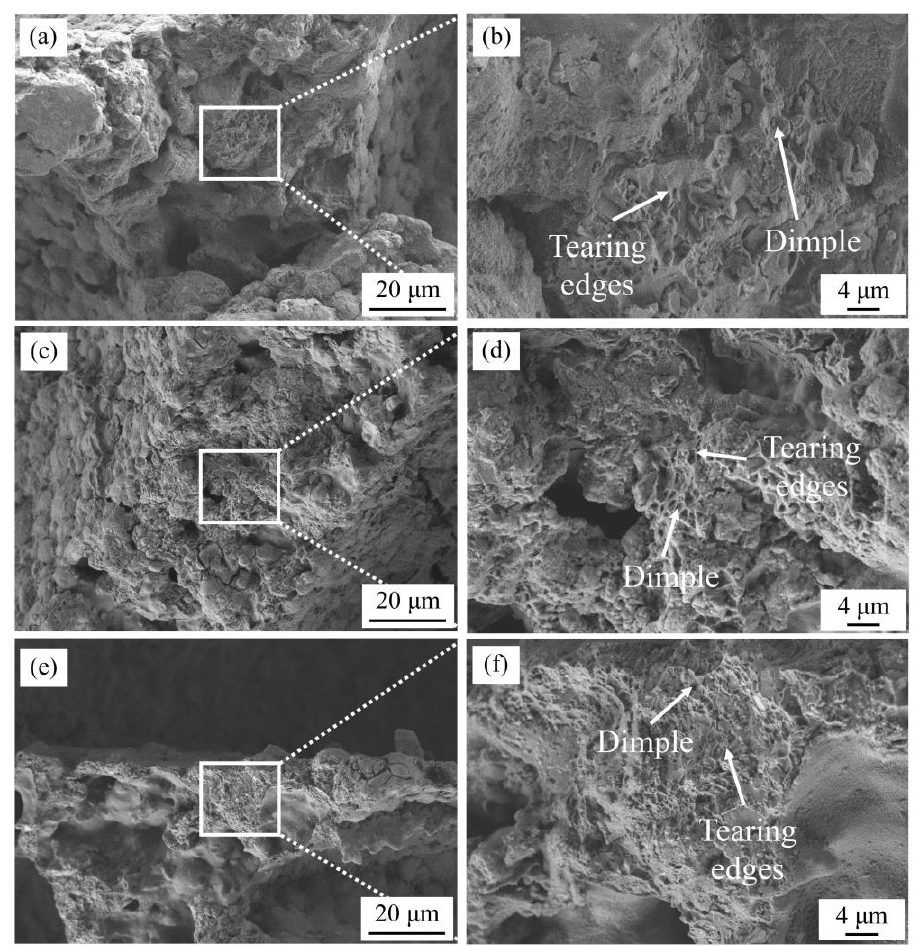
Figure 10. The SEM image of compression fracture of composites with different Zr content ( a , b ) 10Zr; ( c , d ) 20Zr; ( e , f ) 30Zr.